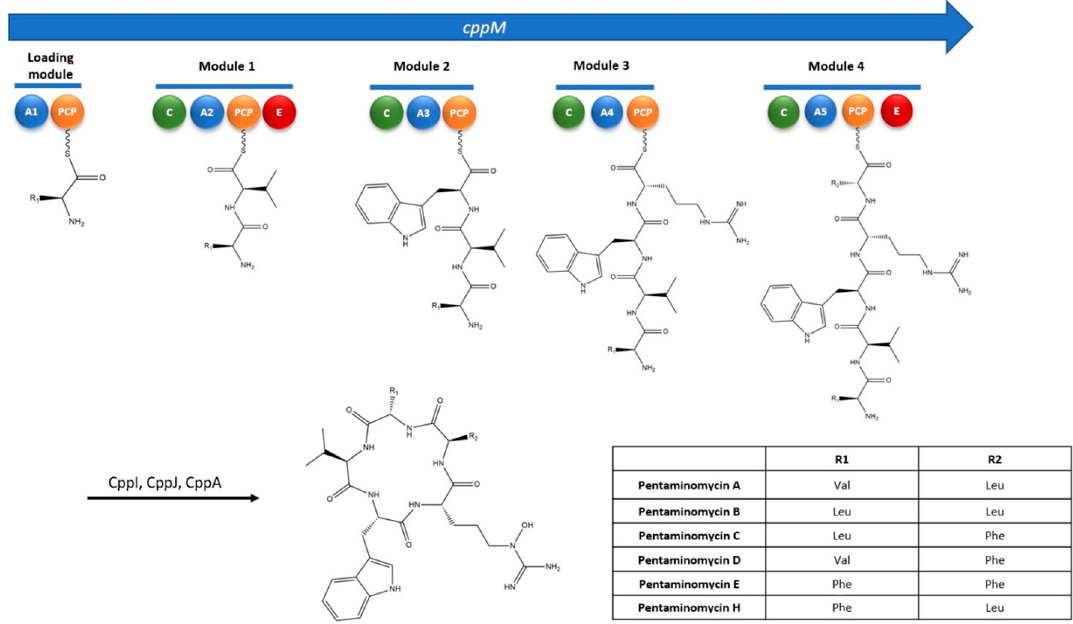
Figure 6. Proposed biosynthetic pathway for the pentaminomycins A–H with the non-ribosomal peptide synthetase CppM modular organization. A1-A5, adenylation domains; PCP, peptidyl carrier protein; C, condensation domain; E, epimerase domain; CppI and CppJ, cytochromes P450; CppA, PBP-type TE.